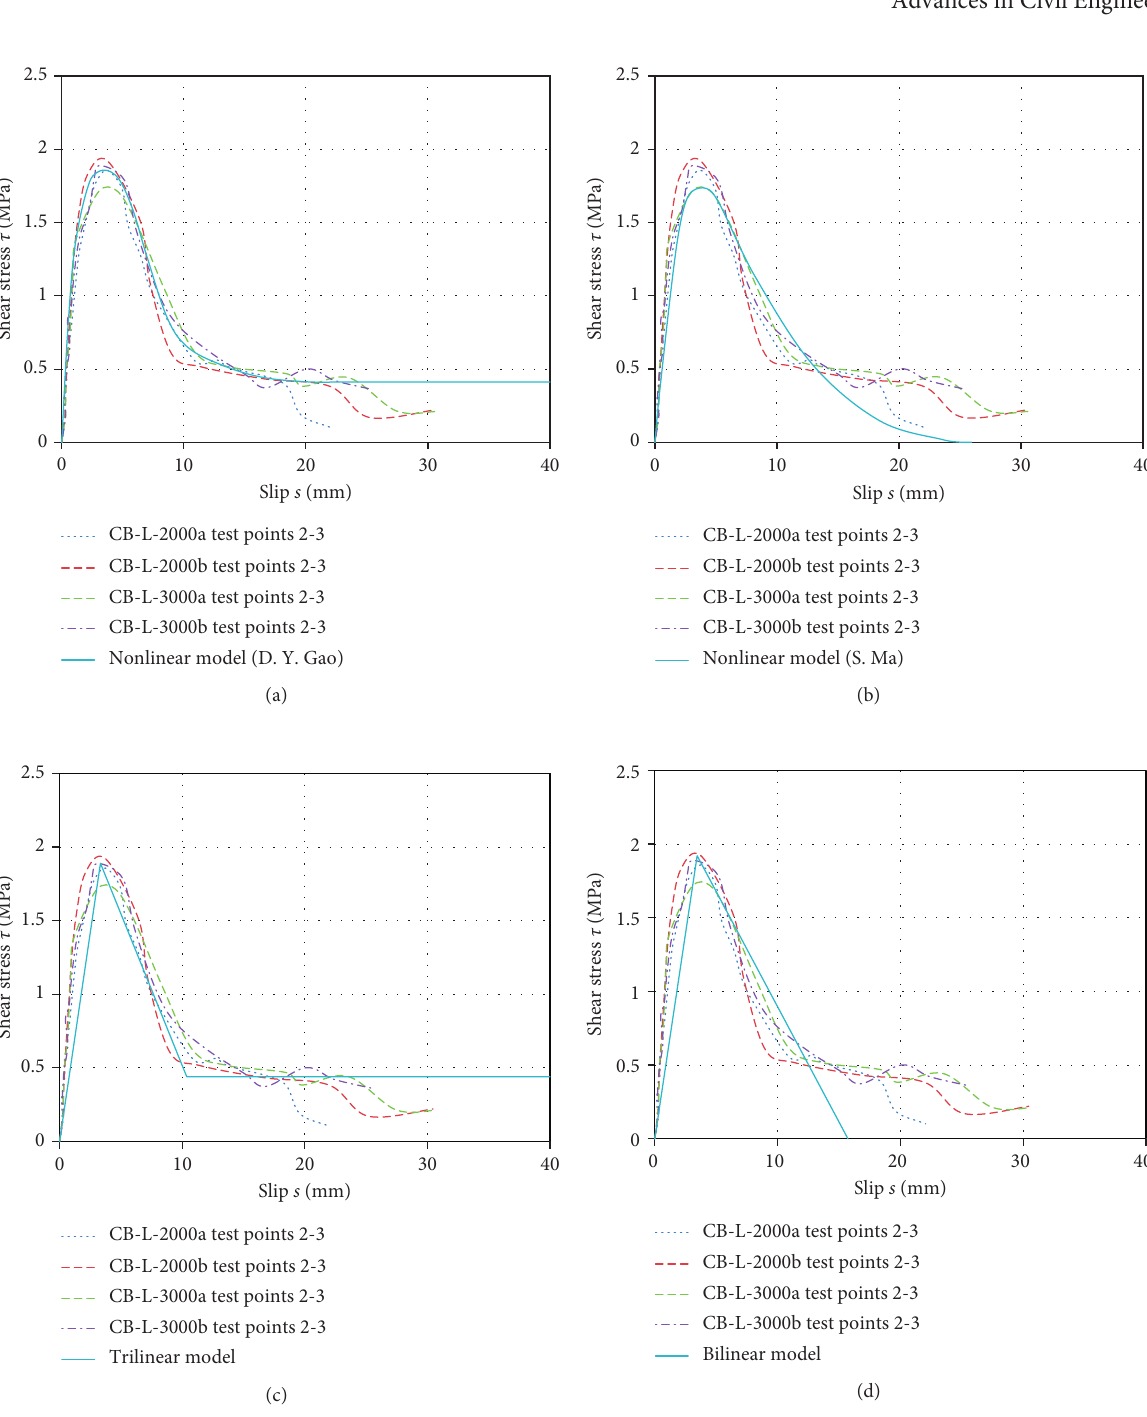
Figure 18: Fitting results of the bond-slip curve and bond-slip model of bamboo bolt-modified slurry interface. (a) Fitting results of the nonlinear model (D. Y. Gao). (b) Fitting results of the nonlinear model (S. Ma). (c) Fitting results of the trilinear model. (d) Fitting results of the bilinear